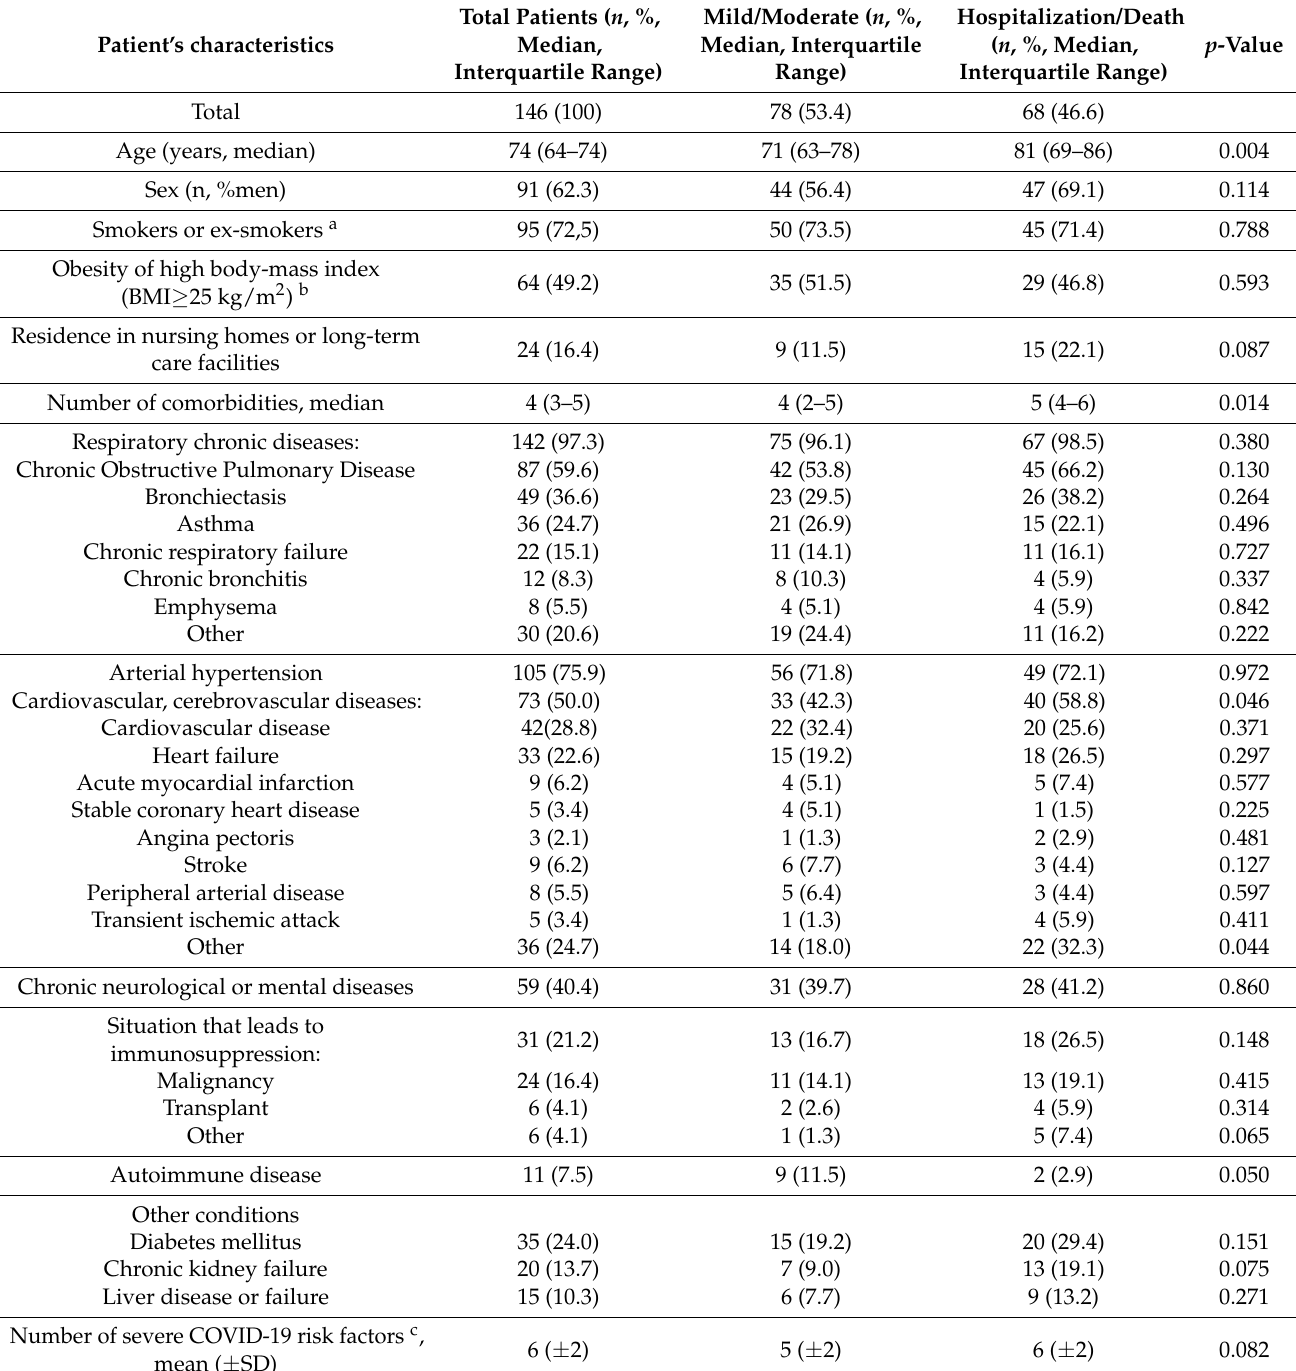
Table 4. Socio-demographic and baseline clinical characteristics of patients with COVID-19 by